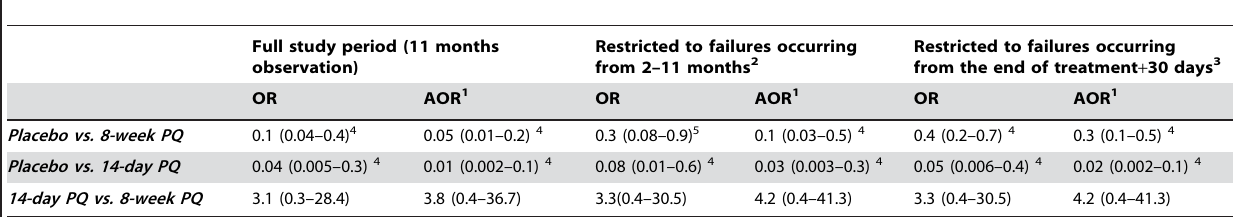
Table 3. Univariate and multivariate logistic regression analysis for treatment failure comparing each group. 95% confidence intervals in parenthesis.